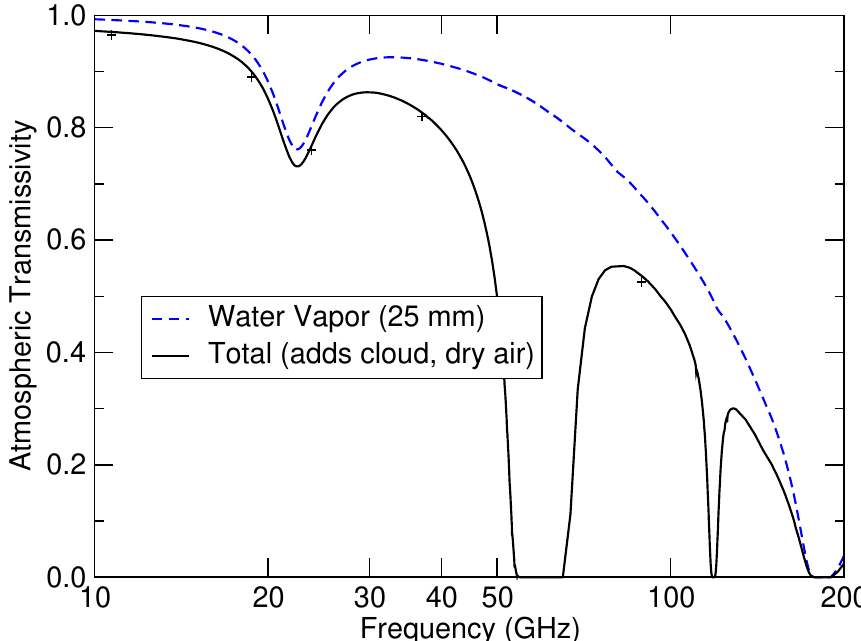
Figure 2. Atmospheric transmissivity as a function of frequency spanning the range from 10 to 200 GHz. The blue line is the water vapor absorption contribution for humid air containing 25 mm columnar water vapor. The black line includes absorption due to water vapor, clouds (0.1 mm columnar cloud liquid water) and dry